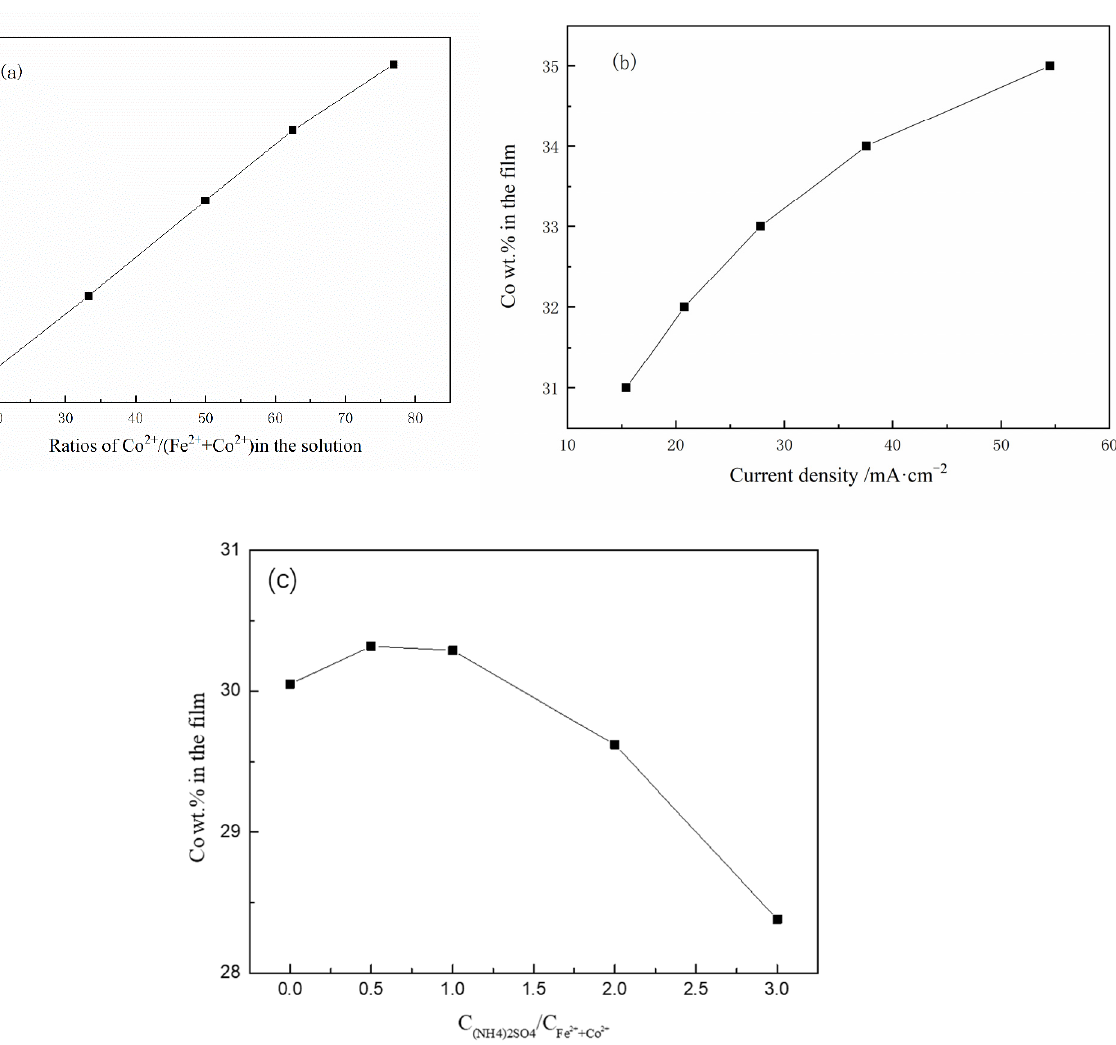
Figure 11. Variation curves of factors influencing the content of elemental Co in the films ( a ) Co 2+ concentration in the solution; ( b ) Current density; ( c ) (NH 4 ) 2 SO 4 concentration.